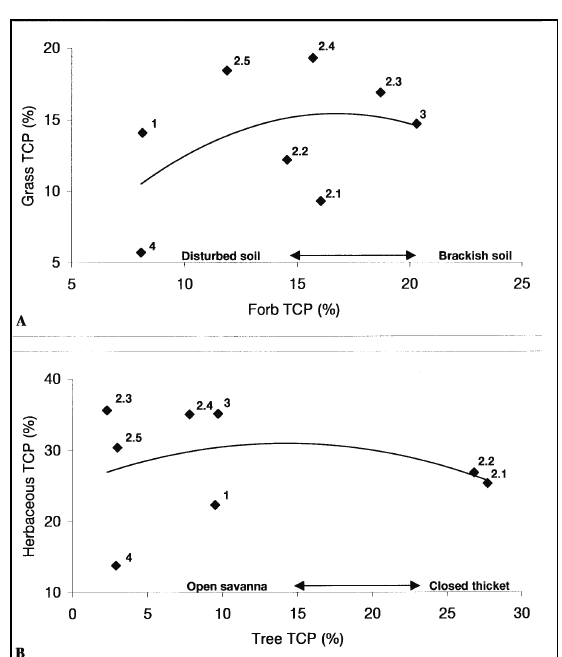
Fig. 3. Total Cover Percentage (TCP) for selected growth forms, as a function of co-existence: (a) grass TCP plotted against forb TCP, and (b) herbaceous (forbs and grasses) TCP plotted against tree